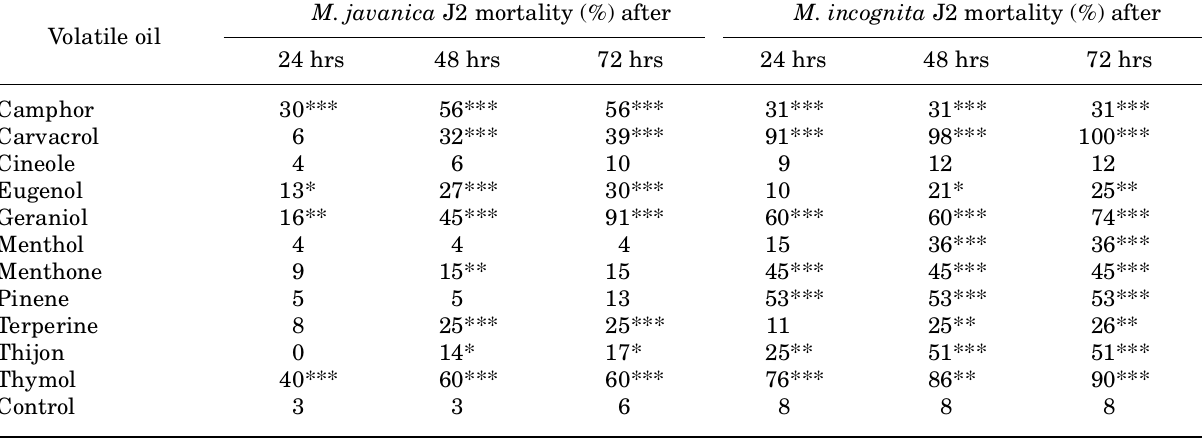
Table 4. Effect of essential oil main component (0.5 µ g ml -1 ) on mortality of second stage juveniles (J2s) of Meloido- gyne javanica and M. incognita